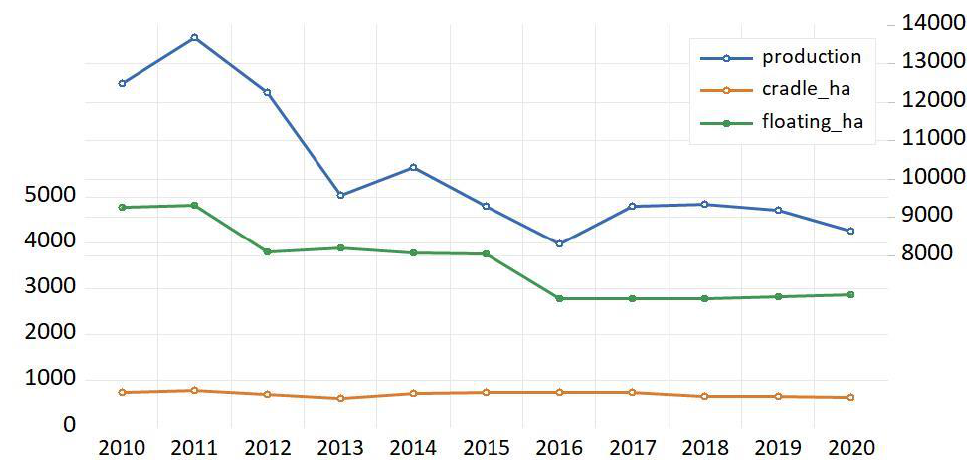
Figure 3. Oyster production in Chiayi County and areas of floating and cradle rack setups between 2010 and 2020. Source: Taiwan Fishery Agency and Chiayi County Government (2010–2020). Note: The left side is the floating and cradle racks aquaculture area (ha), and the right side is the oyster production (mt).